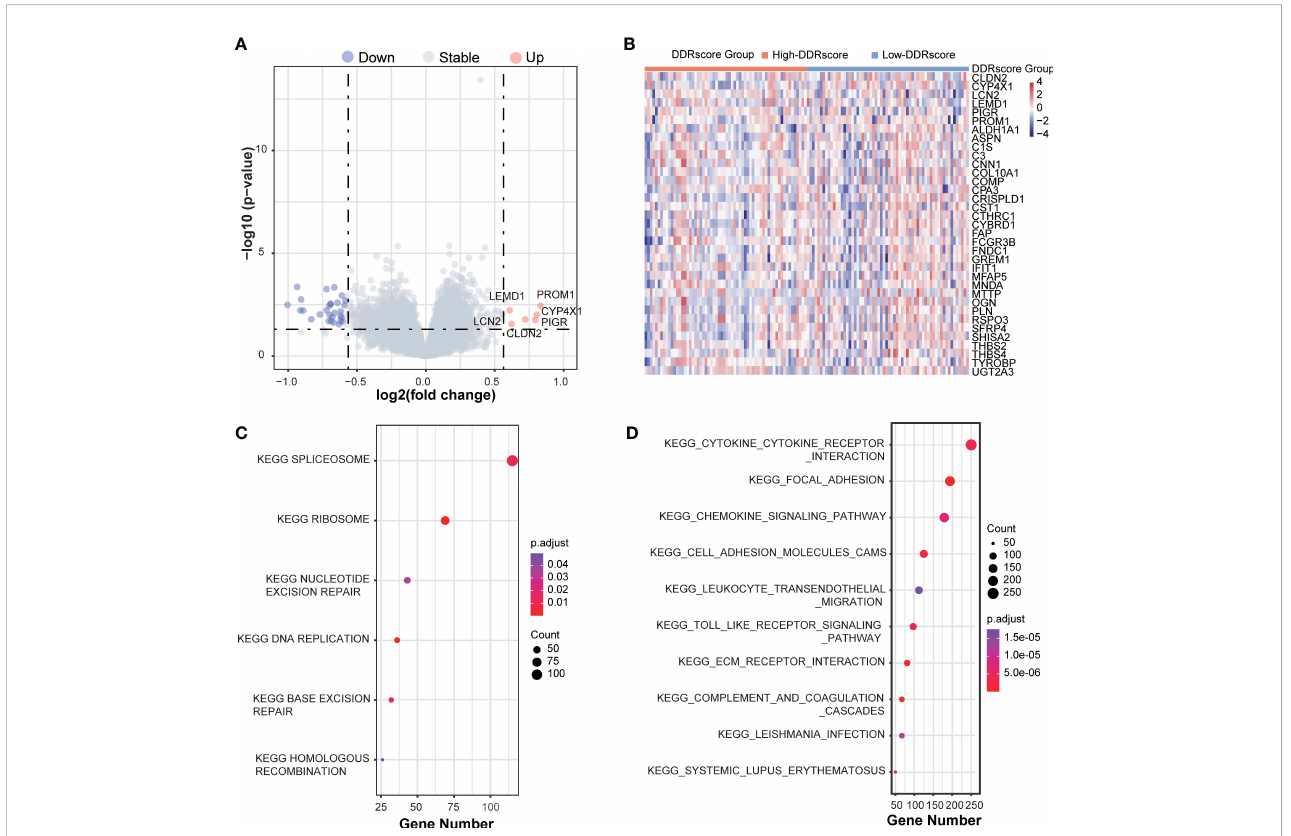
FIGURE 7 The GSEA function analyses the DEGs between high- and low-DDRscore groups in mCRC patients. (A) A volcano plot of DEGs in the high- and low- DDRscore groups. Red indicates upregulated genes, green indicates downregulated genes (high-DDRscore group versus low-DDRscore group), and black indicates no signi fi cant difference. (B) Heatmap showing the expression pro fi les of DEGs in high- and low-DDRscore groups. (C) The top enriched gene pathways in low-DDRscore group from the discovery cohort applying GSEA algorithm. (D) The top enriched gene pathways in high-DDRscore group from the discovery cohort using GSEA algorithm.The color of the ball indicates P -value. Blue bars have a less signi fi cant P -value than red